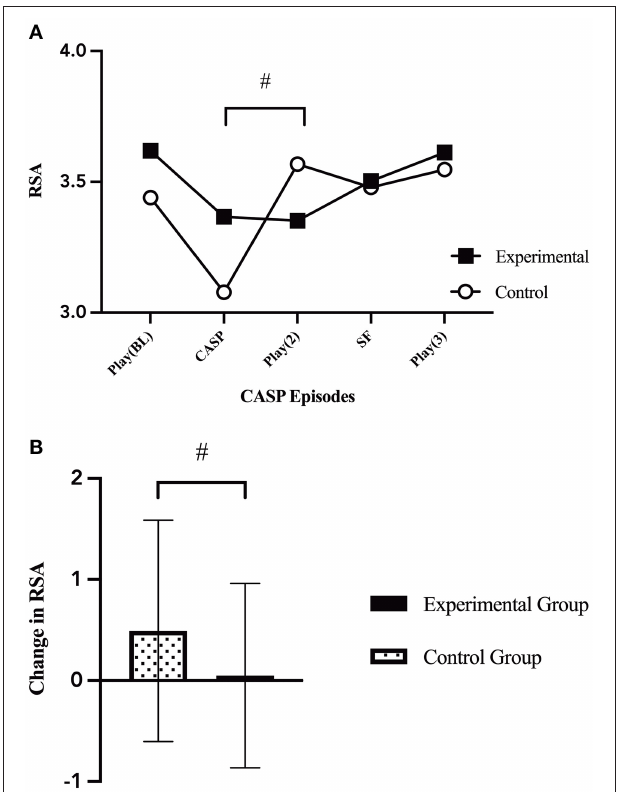
FIGURE 4 | Changes in infant RSA. (A) Infant average RSA throughout the five CASP episodes by group [ F (1, 70) = 1.26, p = 0.294]. There was a marginal trend between grous in the change in infant RSA from the caretaker manipulation episode (E2) to the second play episode (E3) [ F (1, 75) = 3.539, p = 0.064]. (B) Change in infant average RSA from the caretaker manipulation (E2) to the second play episode (E3) [ F (1, 75) = 3.539, p = 0.064], by group (caretaker-stress or caretaker-control condition). p < 0.065 #